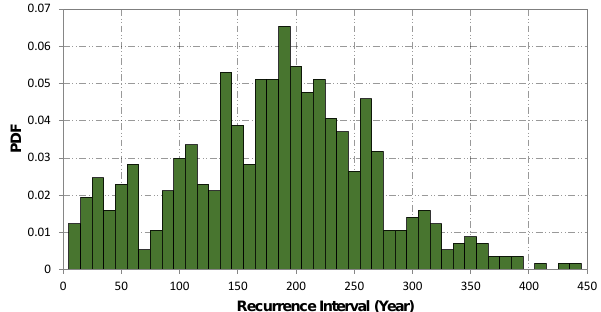
Fig. 6. Probability distribution function (PDF) of recurrence in- tervals for earthquakes with M > 7.0 on the northern San Andreas Fault during the 100000yr simulation. The mean recurrence time is 176yr with C v = 0.48. The bin width is 10yr.